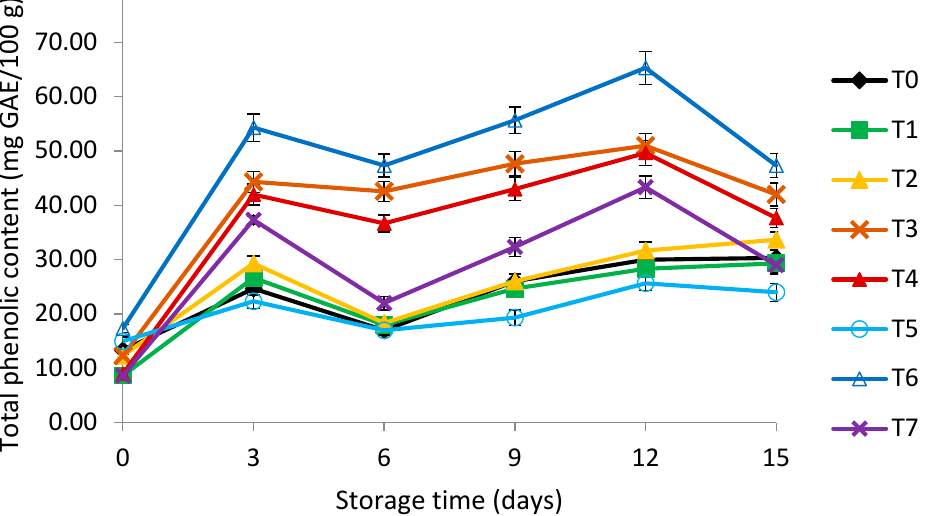
Figure 7. Total phenolic content of control and treated fresh-cut pears stored for 15 days at 8 ± 1 °C. T0—Control; T1—0.2% PE + 1% CaCl 2 ; T2—0.2% PE + 1% CaCl 2 + 0.2% PS; T3—0.2% PE + 1% CaCl 2